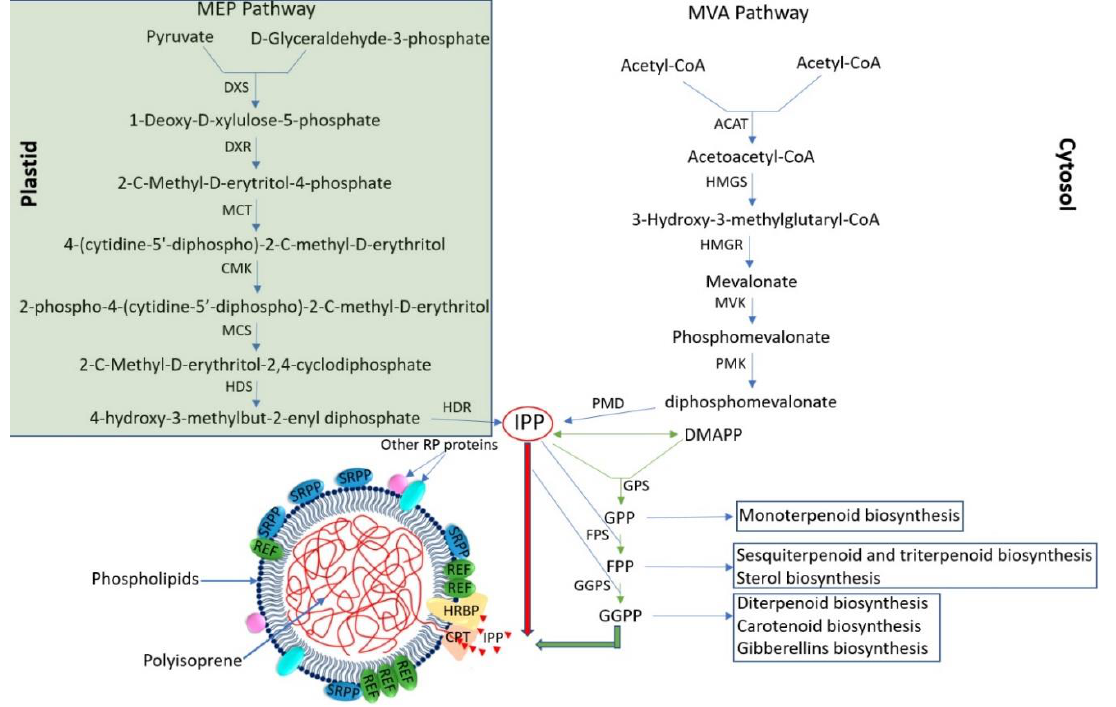
Figure 2. The pathway of natural rubber, 2-C-methyl-D-erythritol-4phosphate (MEP) and mevalonate (MVA) in Taraxacum kok-saghyz . DXS—1-Deoxy-D-xylulose-5-phosphate synthase; DXR—1-Deoxy-D-xylulose-5-phosphate reductoisomerase; MCT—2-C-Methyl-D-erytritol-4-phosphate cytidyl transferase; CMK—4-(cytidine-5′-diphospho)-2-C-methyl-D-erythritol kinase; MCS—2-C-methyl-